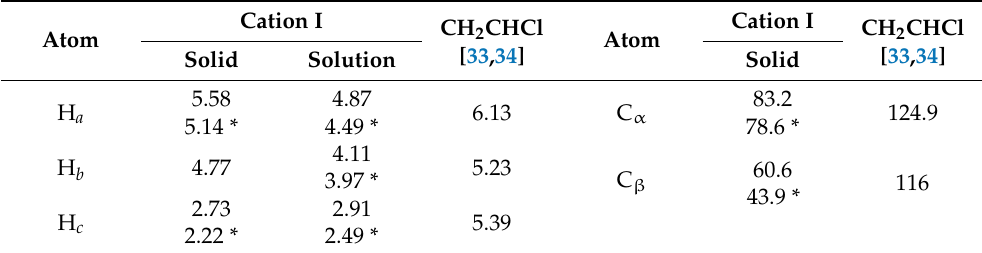
Table 1. 1 H/ 13 C NMR chemical shifts (ppm) of the chloronium cation in the (C 2 H 3 ) 2 Cl + {Cl 11 − } salt in comparison with those of vinyl chloride (the signals marked with an asterisk belong to the second C 2 H 3 group, which differs from the first one).